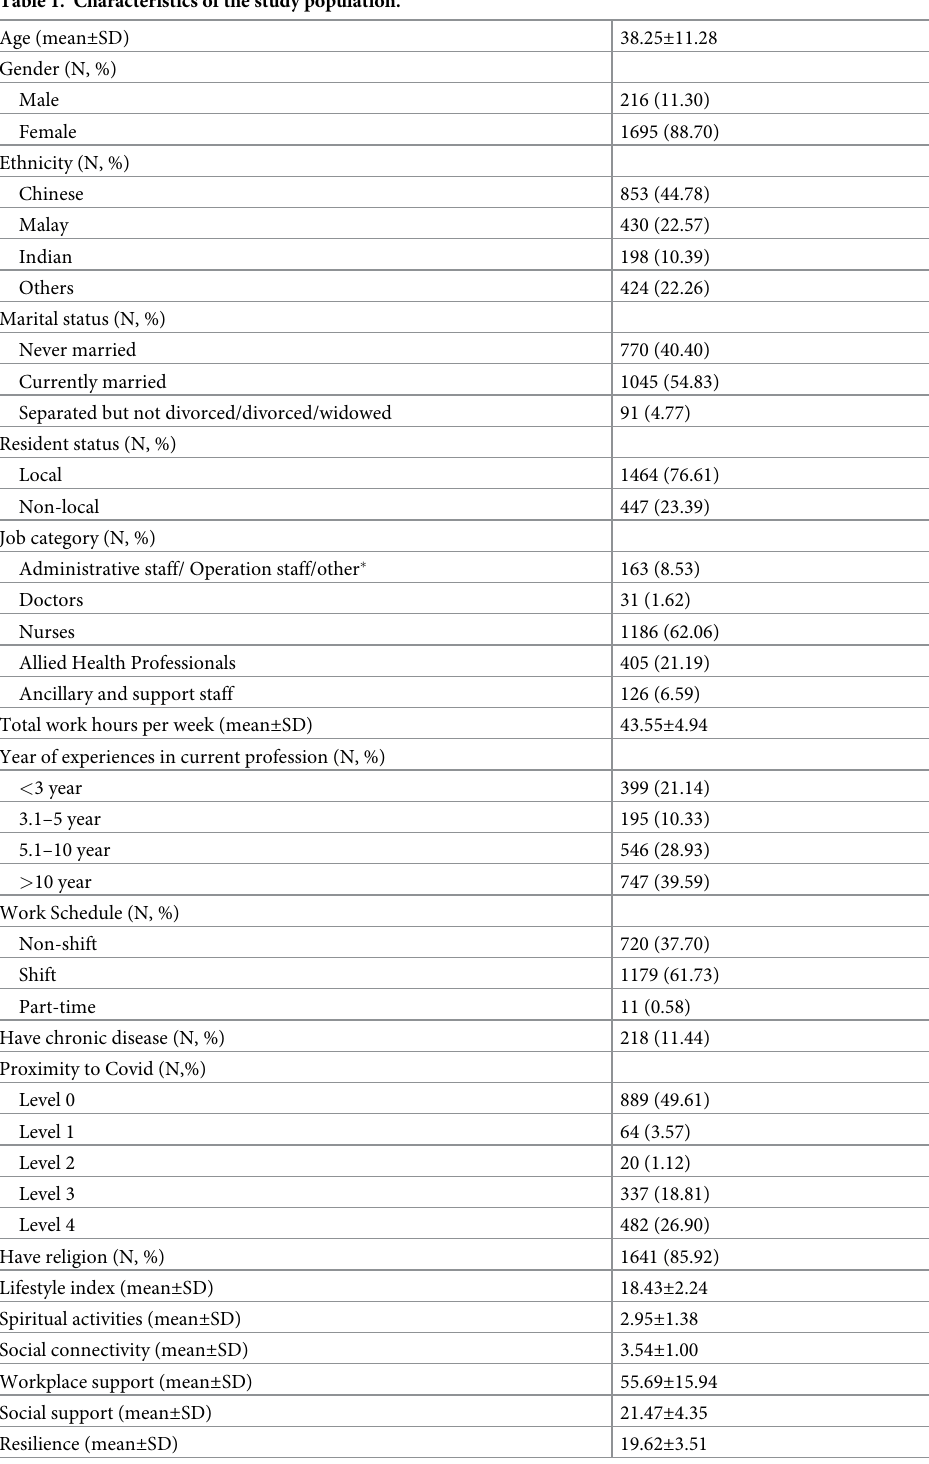
Table 1. Characteristics of the study